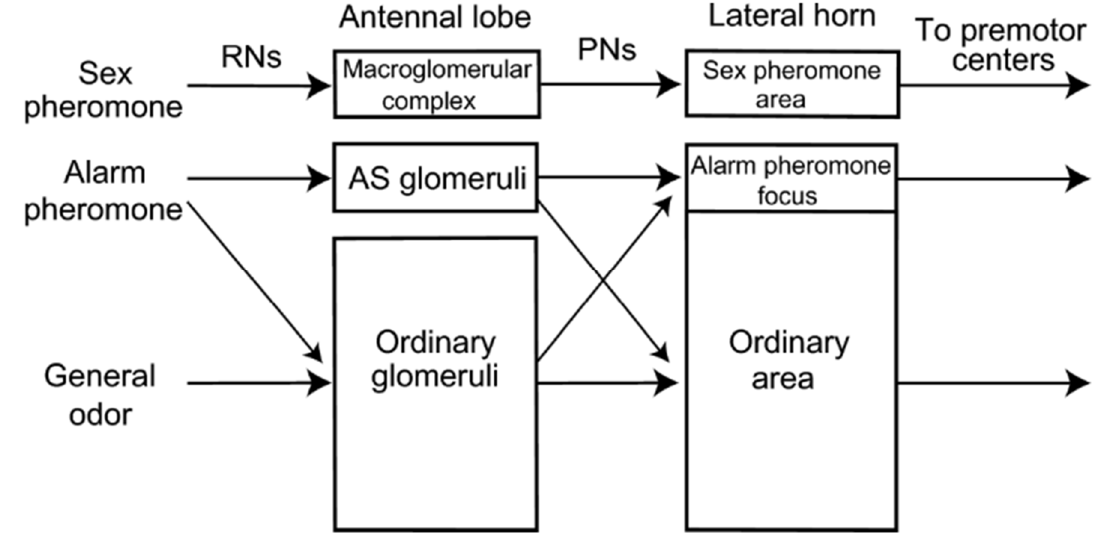
Figure 5. Model of alarm pheromone processing in the insect brain. Two parallel pathways are organised for the processing of odours in the insect brain. The first involves a direct path, called the “labelled line” architecture, where specific structures such as ‘alarm pheromone sensitive’ (AS) glomeruli as observed in the brain of Camponotus ant species are involved in processing to higher brain areas such as the lateral horn. This is compared to the processing of sex pheromones in male moths, which possess a specialised structure called the macroglomerular complex. The second, called the “across fibers” architecture is observed in species like Apis mellifera which do not possess specialised glomeruli for alarm pheromone processing. Here, the representation of the alarm pheromone is overlapped with general odours in the glomeruli and the lateral horn.. Reprinted with permission from [119] , 2010, Prof. Makoto Mizunami.